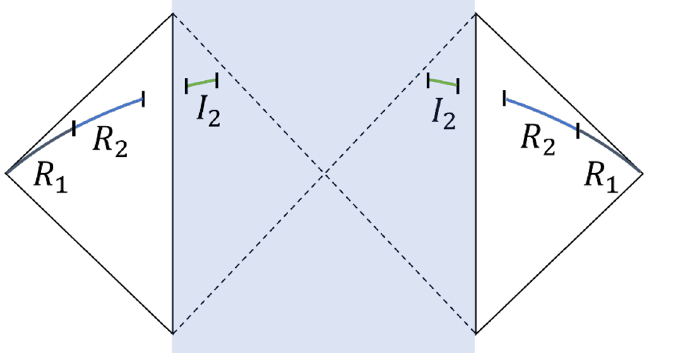
Figure 22 . Two subsystems R 1 and R 2 in the radiation. The coordinates (from left to right) are P 0 : ( b 2 , − t + πi ) , P 0 : ( b 1 , − t + πi ) , P 0 : ( − a 1 , − t + πi ) , P 0 1 2 3 ( − a 1 , t ) , P 0 : ( b 1 , t ) and P 0 : ( b 2 , t ) . Here the island of R 2 is made up of two disjoint 7 8